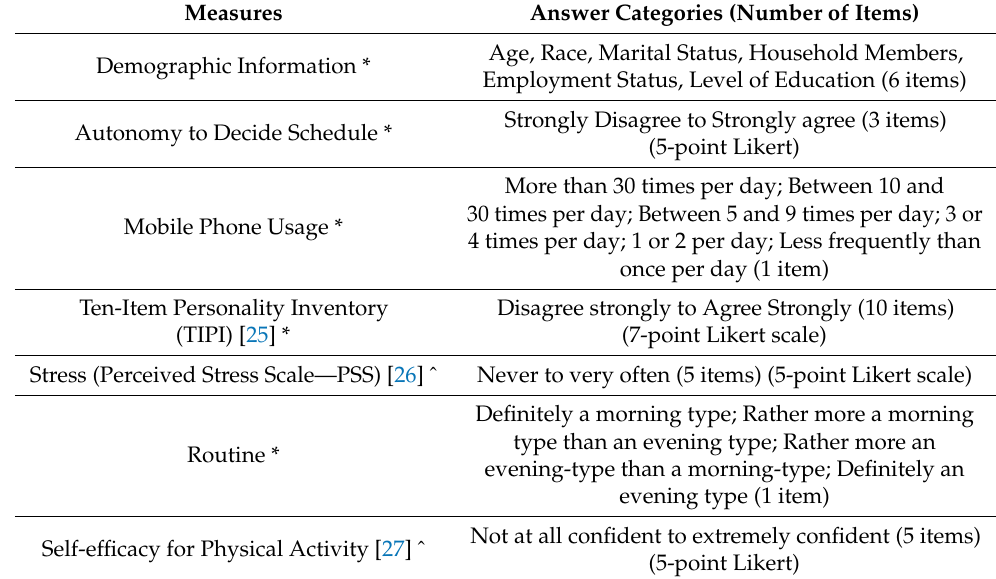
Table 1. Baseline and Follow-up